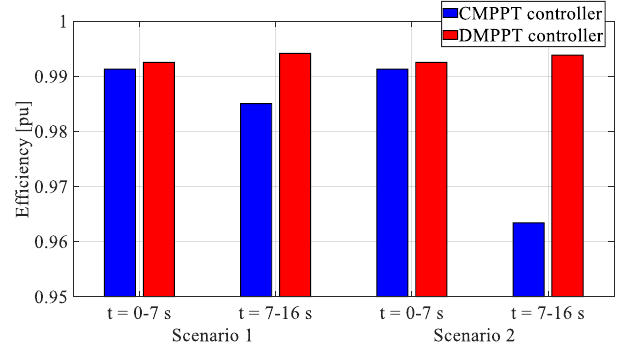
Figure 11. Efficiency of entire system. Figure 11. E ffi ciency of entire